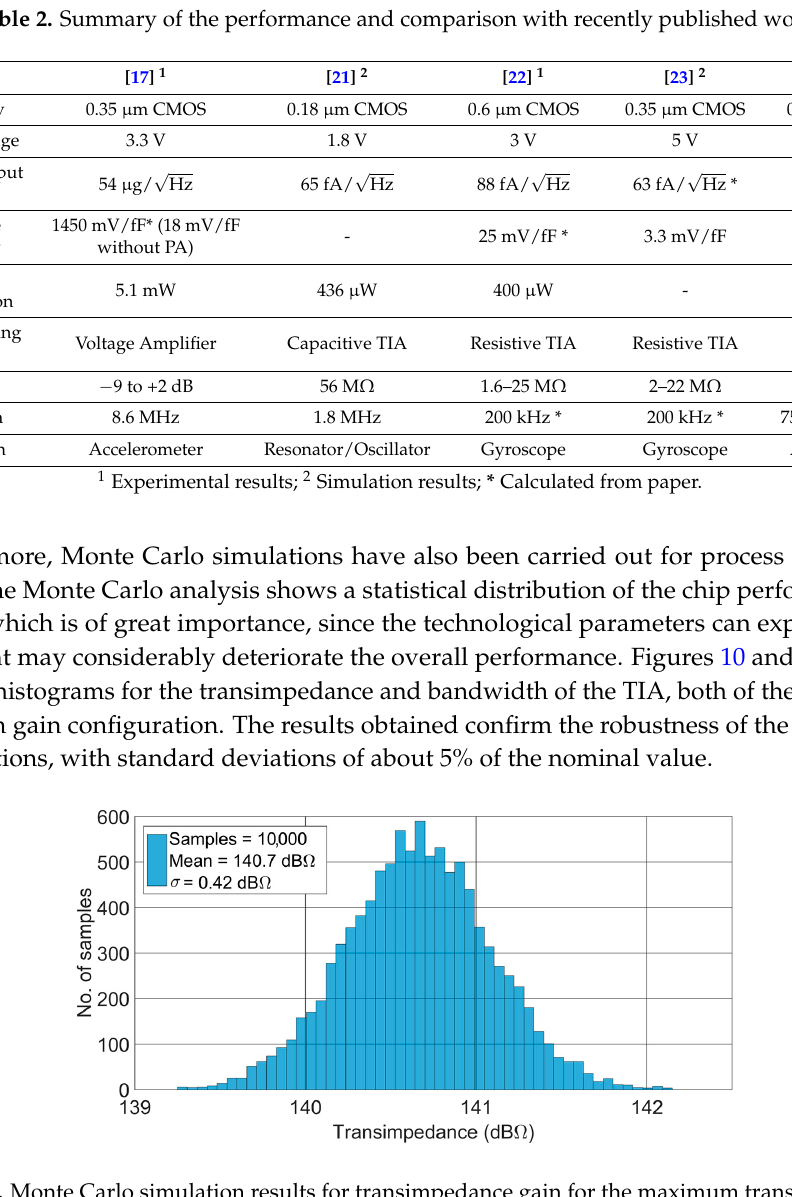
Figure 10. Monte Carlo simulation results for transimpedance gain for the maximum transimpedance configuration, 140 dB Ω , showing a standard deviation, σ , of 0.42 dB Ω .